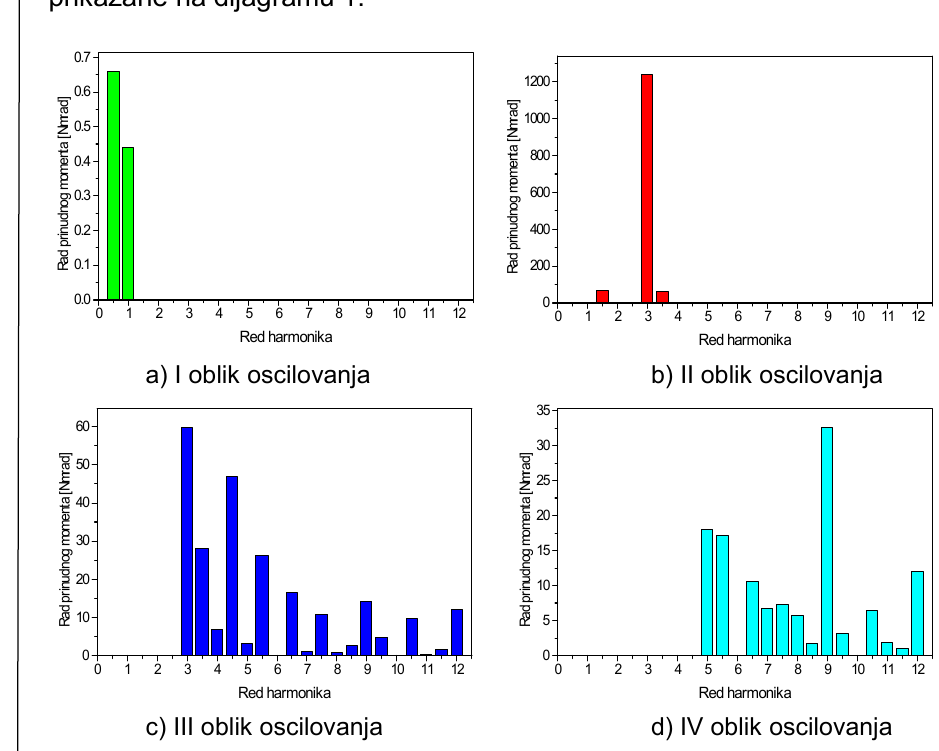
Dijagram 1 – Rad prinudnog momenta za prva č etiri oblika oscilovanja sistema Rad prinudnog momenta na rezonantnim režimima dovodi do pove- ć anja amplituda oscilovanja, koje bi neograni č eno rasle kada ne bi posto- jali otpori na koje se ovaj rad troši. Kod realnih sistema, kakav je sistem prenosa snage na brodu RML-341, to nije slu č aj, jer postoje unutrašnji (trenje u prigušiva č u torzionih oscilacija, ležištima, materijalu i dr.) i spo- ljašnji otpori (trenje propelera o vodu, oscilacije nosa č a motora). Razmatraju se i oni harmonici koji se nalaze u radnoj oblasti motora ili u njenoj blizini. Od svih redova koji se nalaze u pomenutom podru č ju od po- sebnog su zna č aja oni sa ve ć im amplitudama, jer ulažu ve ć u energiju u oscilovanje sistema. Iz dijagrama 1 ne može se zaklju č iti koji se harmonici nalaze u radnoj oblasti motora, pa su u tabeli 6 prikazani redovi harmonika i odgovaraju ć i brojevi obrtaja za pojedine oblike oscilovanja (dijagram